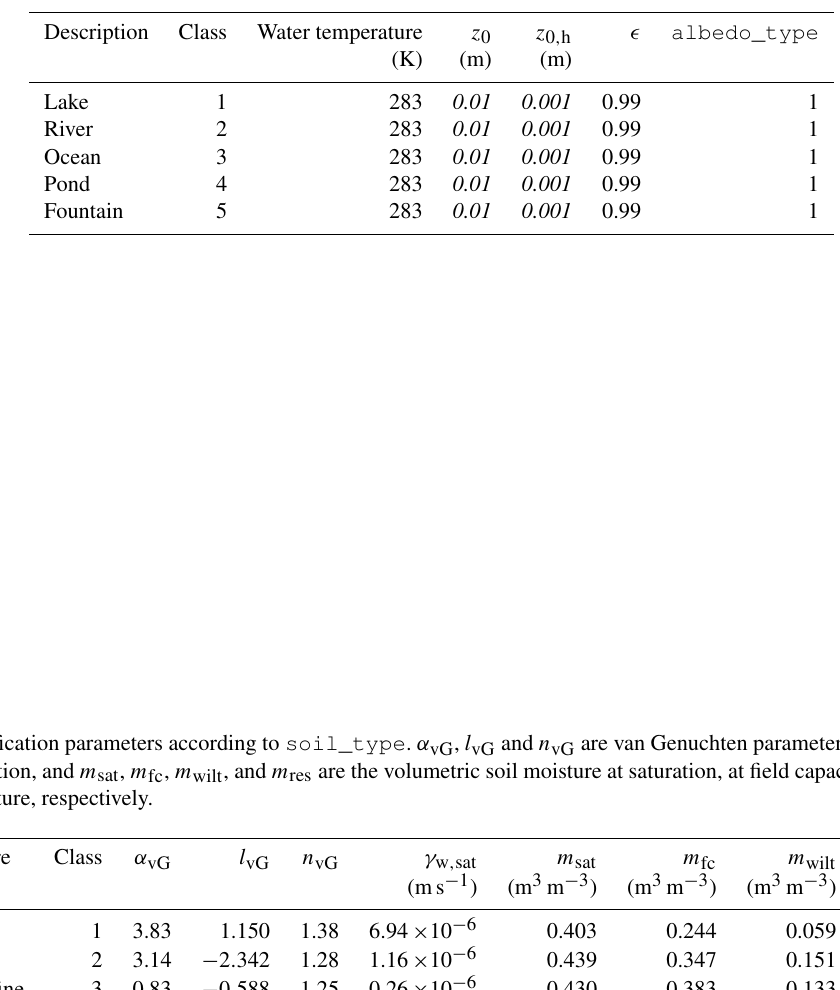
Table A5. Water classification parameters according to water_type . Italic values are preliminary. z 0 and z 0 , h are the roughness lengths for momentum and heat, respectively, and (cid:15) is the surface emissivity.